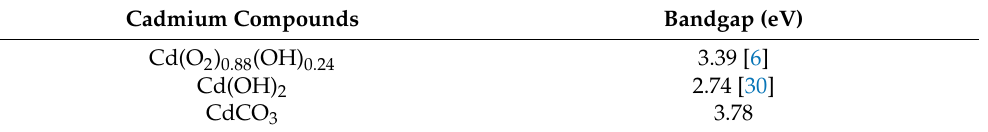
Table 1. Bandgap energies of different cadmium compounds used as precursor films.